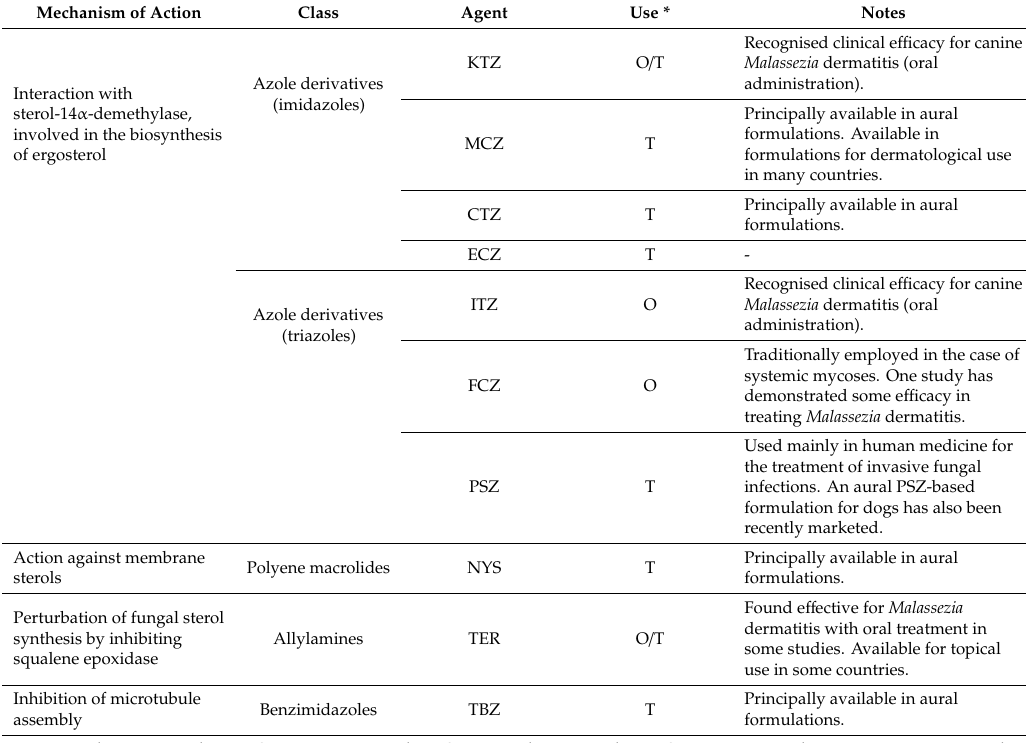
Table 1. Antifungal agents used to treat Malassezia dermatitis and otitis in the